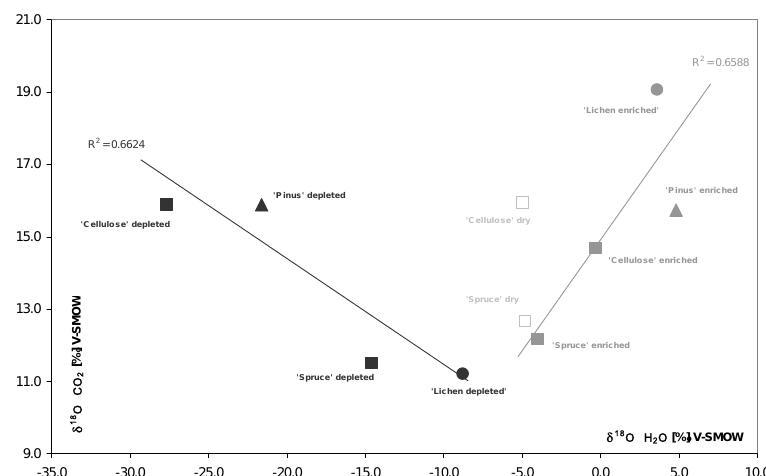
Fig. 6. Isotopic signature of the combustion-derived CO 2 and H 2 O from four different kinds of fuel (black symbols are samples wetted with the depleted water, grey ones with the enriched water). The open symbols refer to the combustion signatures of the dry reference substance from which we received a sufficient amount of combustion water for analysing (“Spruce” and “Cellulose”). Values are given on the VSMOW